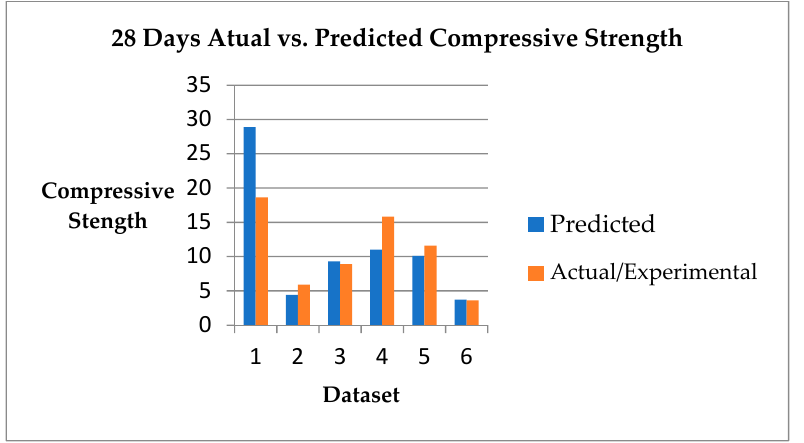
Figure 5. Graphical representation of experimental value (actual) and projected split tensile strength of fly-ash, calcined-clay-based geopolymer concrete. Table 8. The training phase (split tensile strength) with available RFR models’ yielded statistical data from the applied prediction models.